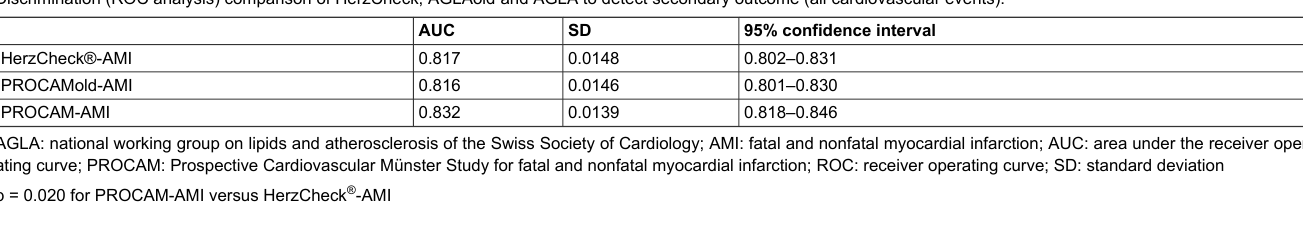
Table 6: Cox proportional hazards model survival analysis for the primary outcome using the covariates HerzCheck ® , PROCAM, SCORE and TPA.